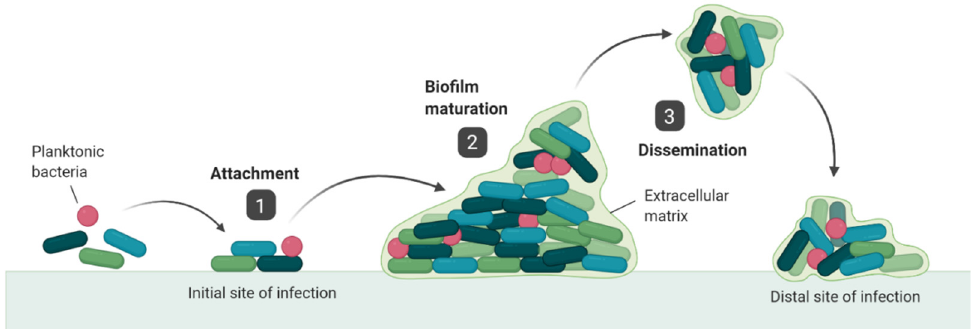
Figure 1. The biofilm life-cycle. The biofilm life-cycle consists of three main stages: (1) Attachment: Planktonic, free-living bacteria adhere to a surface. This is mediated by a combination of physical factors (e.g., surface hydrophobicity, electrostatic interactions) and bacterial appendages (e.g., pili, flagella). (2) Biofilm maturation: Adherent bacteria proliferate to form microcolonies. Bacteria produce Extracellular Polymeric Substances (EPS), EPS matrix stabilises the bacterial network. (3) Dissemination: A subset of bacteria detach, regain some of the characteristics of planktonic bacteria and colonise distal sites.